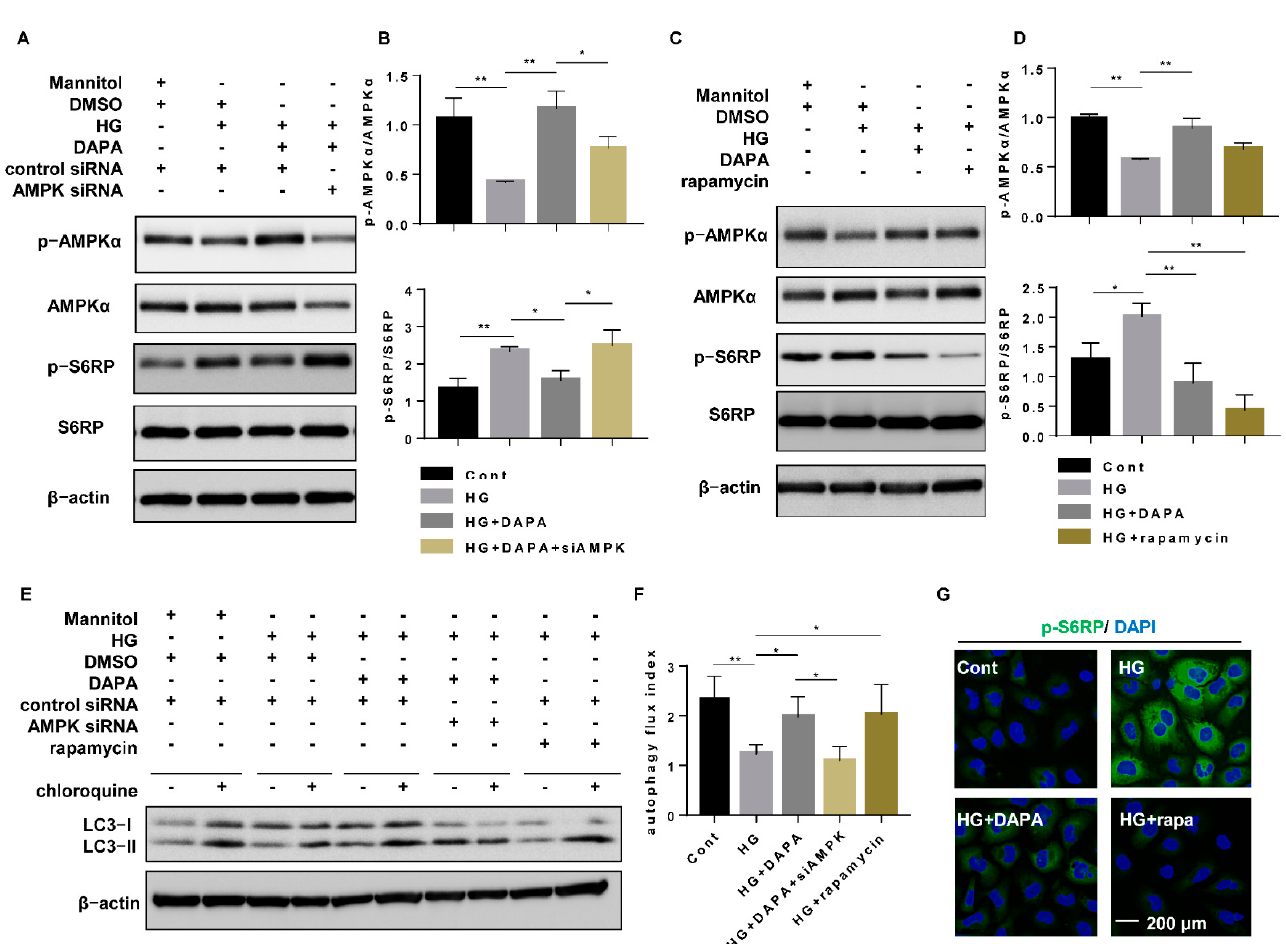
Figure 3. Dapagliflozin restored HG-impaired autophagy via the AMPK/mTOR pathway. ( A ) HK-2 cells were transfected with AMPK siRNA (200 nM) or control siRNA for 6 h and then incubated with Cont, HG (30 mM), or HG (30 mM) with dapagliflozin (20 μ M) for 48 h. The p-AMPK, AMPK, p-S6RP, and S6RP levels were assessed by western blotting. ( B ) Densitometric evaluation of ( A ) (n = 3). ( C ) HK-2 cells were incubated with Cont, HG (30 mM), HG (30 mM) with dapagliflozin (20 μ M), or HG (30 mM) with rapamycin (0.4 μ g/mL) for 48 h, and the p-AMPK, AMPK, p-S6RP, and S6RP levels were assessed by western blotting. ( D ) Densitometric evaluation of ( C ) (n = 3). ( E ) Quantitative autophagic flux is represented by western blots of LC3-II inHK-2 cells cultured with Cont, HG, dapagliflozin, dapagliflozin with siAMPK, and rapamycin in the presence and absence of chloroquine (50 μ M for 1 h). ( F ) Densitometric evaluation of ( E ) (n = 5). All data represent means ± standard deviation (SD). ( G ) Immunofluorescence of p-S6RP in HK-2 cells cultured with Cont, HG, dapagliflozin, dapagliflozin with siAMPK, and rapamycin. * p < 0.05 vs. the indicated group, ** p < 0.01 vs. the indicated group. Cont, control; HG, high glucose; DAPA, dapagliflozin; siCON, control siRNA; siAMPK, AMPK siRNA; and CQ, chloroquine.